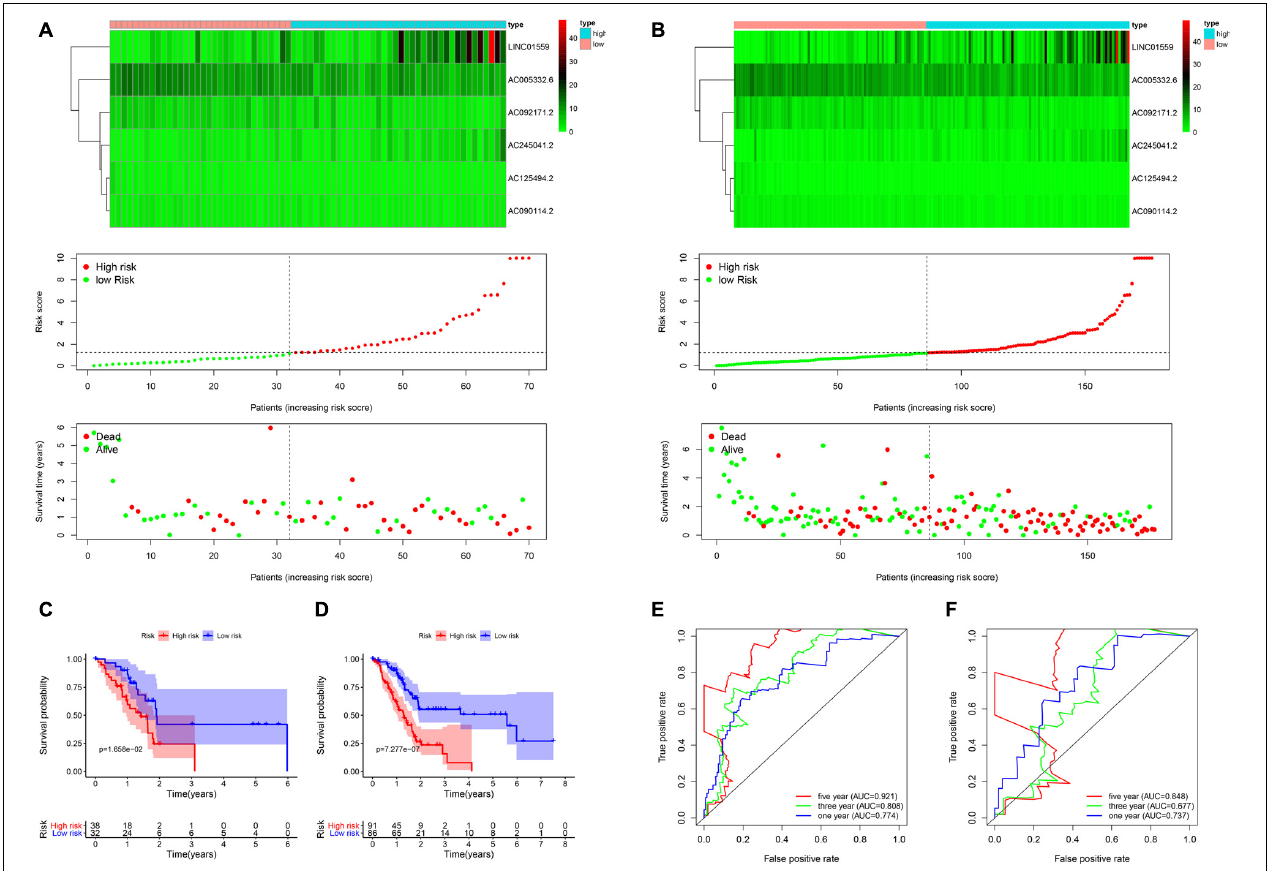
FIGURE 2 | The validation of the risk model in the validation cohort and entire cohort. (A,B) Correlation between the prognostic signature and the overall survival of patients in the validation set (A) and entire set (B) . The autophagy related lncRNAs levels (upper), risk scores (middle), survival time (below). (C,D) Kaplan–Meier curves of overall survival in the training cohort (C) and the validation cohort (D) stratified by risk scores. (E,F) Receiver operating characteristic (ROC) curve analysis for the survival prediction model in the training cohort (E) and the validation cohort (F)